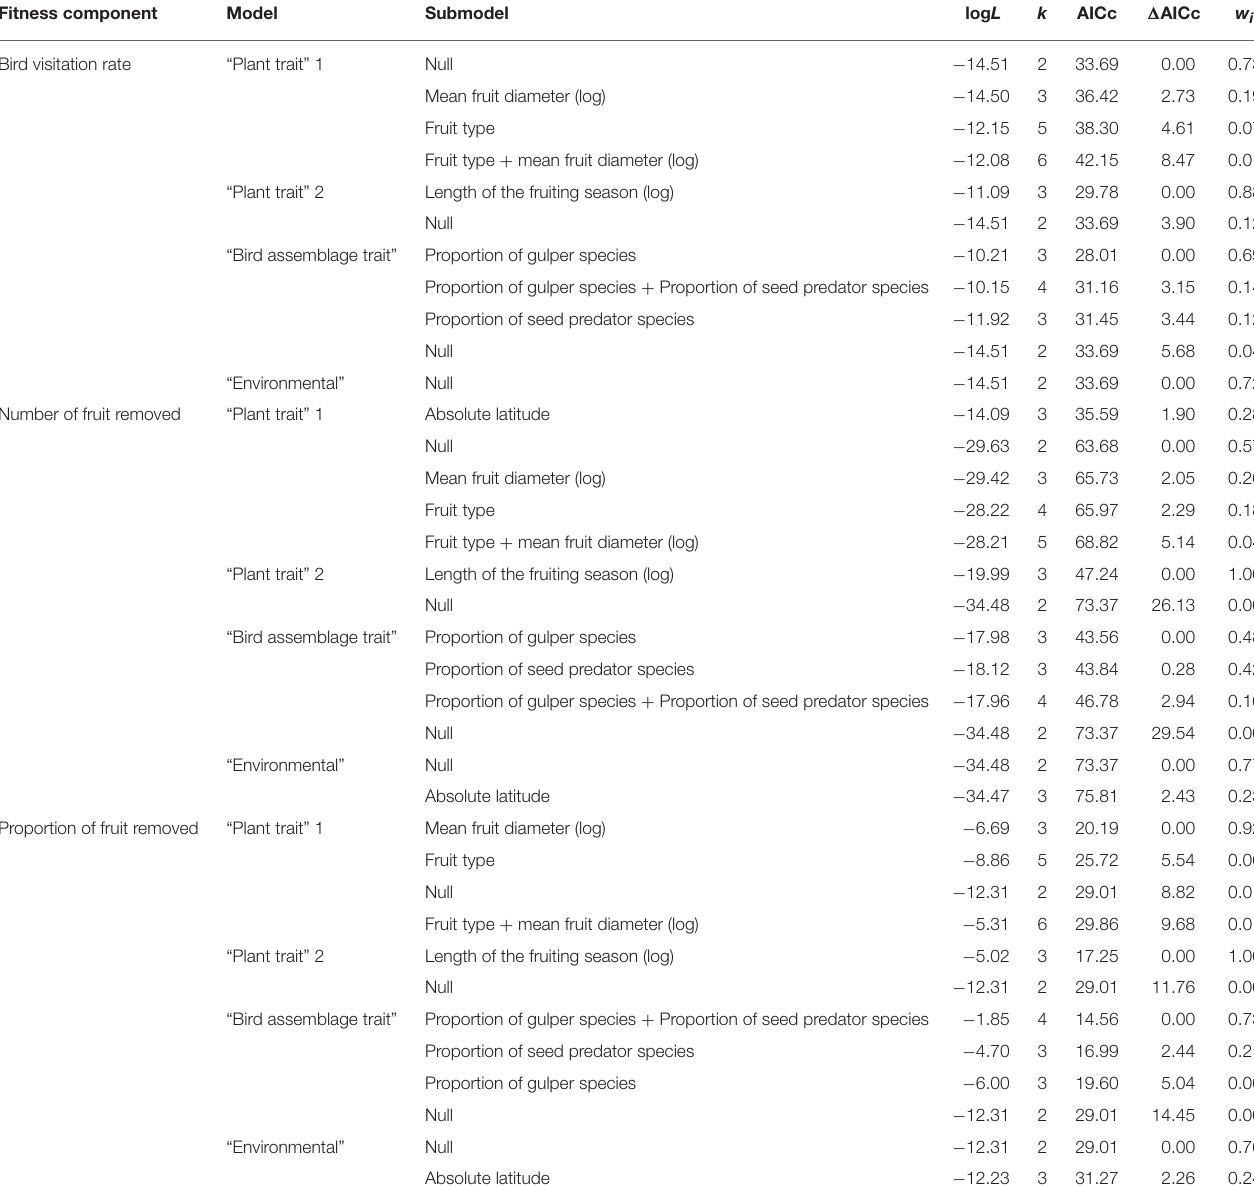
TABLE 2 | Set of models relating explanatory variables with bird-mediated selection on fruit crop size. Fitness